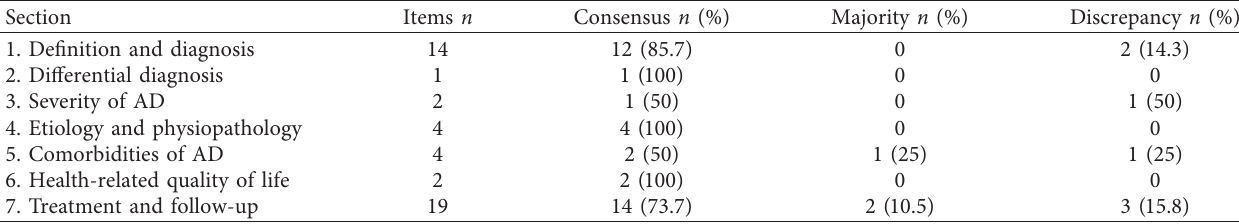
Table 1: General results obtained for the different sections of the questionnaire.